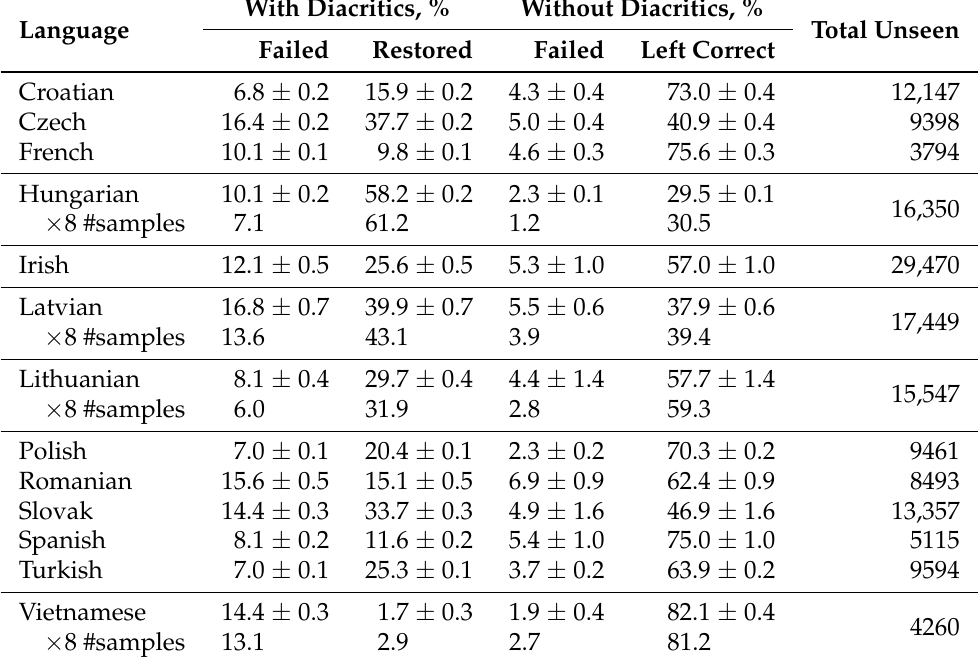
Table 7. The confusion matrix of the unseen word diacritics restoration performance by the ByT5 model. Unseen words with and without diacritics are presented separately. The last column depicts the total number of unseen words for each language.